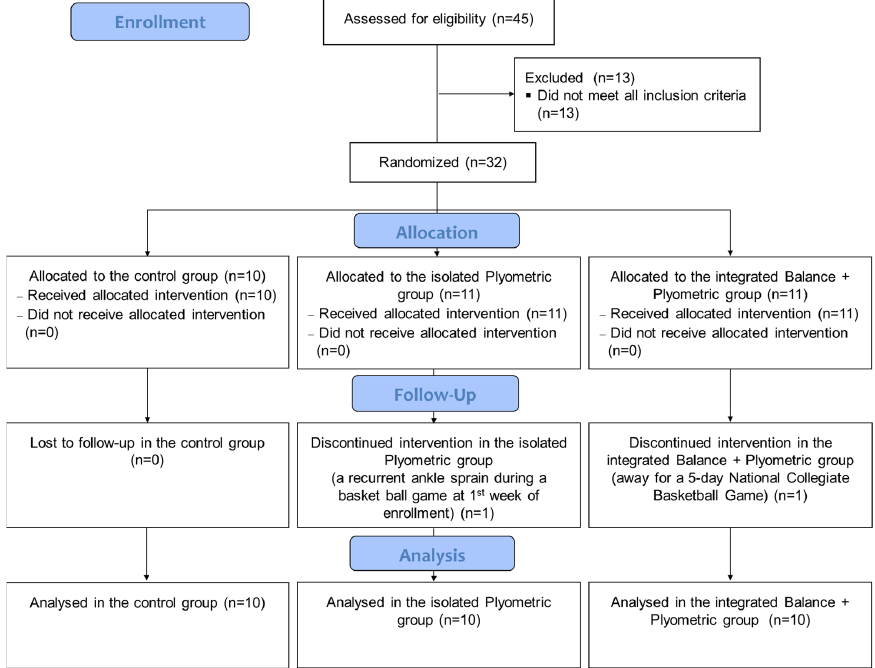
Figure 1. The flow diagram of recruited participants. Table 1. Subject characteristics and history of ankle sprain in each group (mean ± SD).